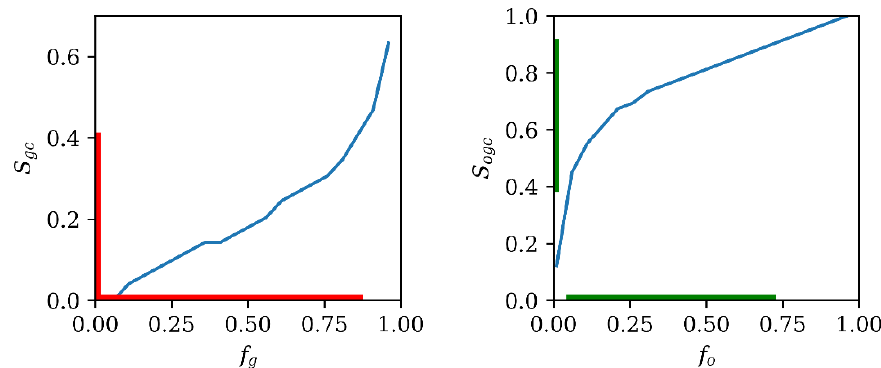
Figure 3. An example of the mapping between the uncertainty ranges for S gc and f g ( left graph; red lines) and for S ogc and f o ( right graph; green lines) using the dependencies S gc = S gc and S ogc = S ogc ( f o ) (blue lines) for a fixed coordination number Z = 24.